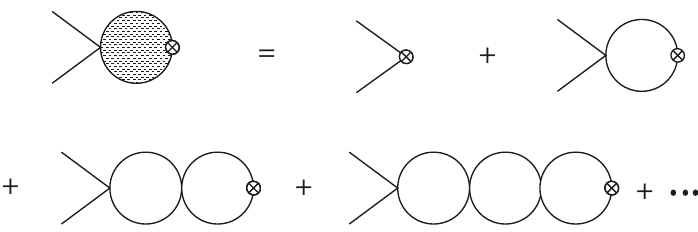
Figure 2 . Chain of scalar loop diagrams connecting to the composite operator h (cid:22)(cid:23) . The operator appears in an interaction vertex that is represented by the small circled